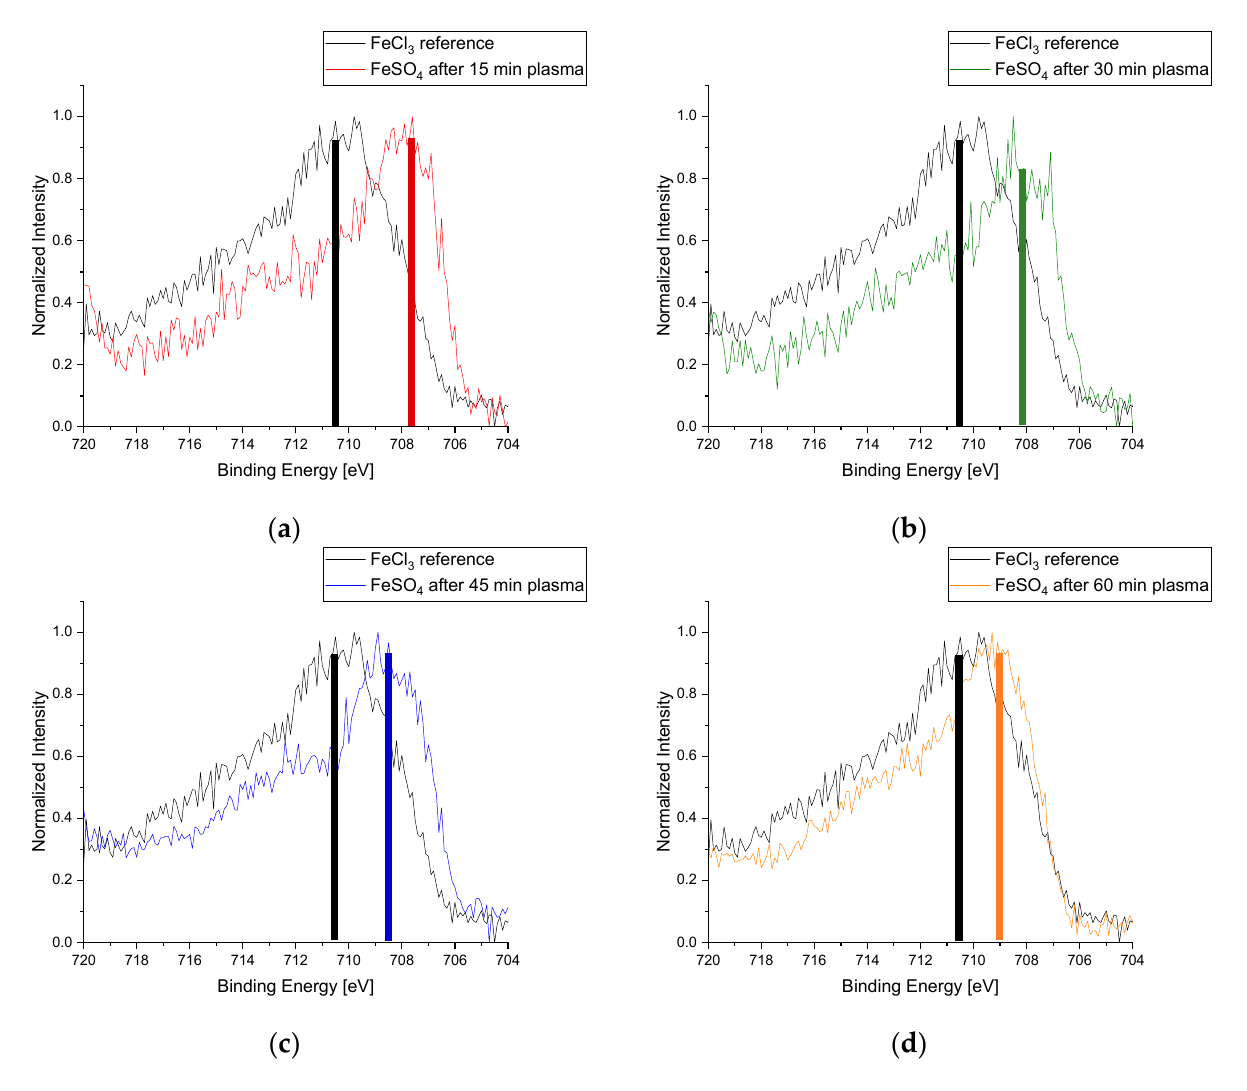
Figure 15. Plot of the respective Fe-2p 3 signal of iron(II) sulfate after 15 ( a ), 30 ( b ), 45 ( c ), and 60 min ( d ) treatment time at low pressure with Varigon plasma compared with the reference (black signals in the plots). Similar to the FeCl 3 samples, a successful reduction can be seen in these spectra by the shift of the plasma-treated samples to lower binding energies. It is noticeable that the shift consistently decreases with a higher treatment duration. The color columns in the pictures visualize the peak shift after plasma treatment compared to the reference (black column).